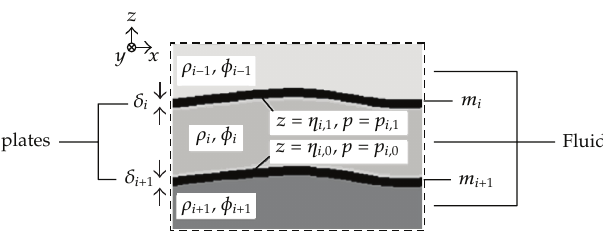
Figure 1: Thin plates and multilayer